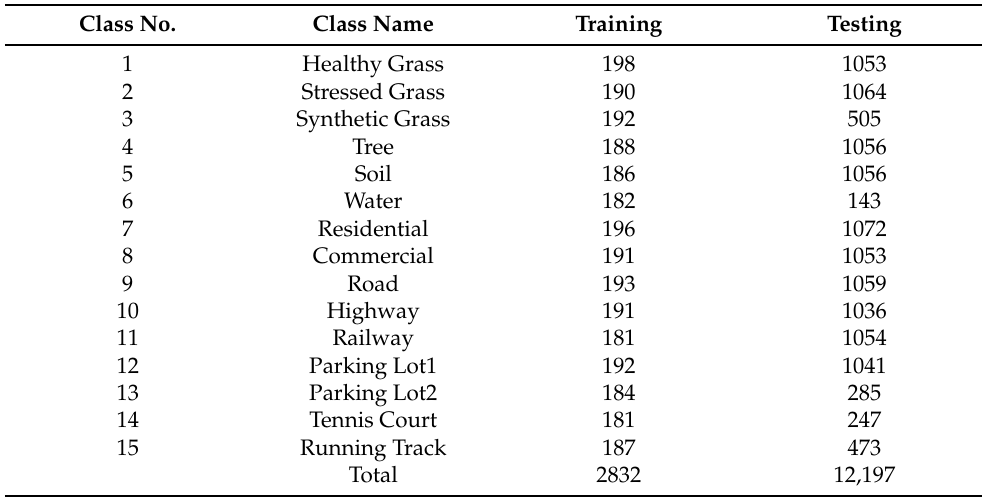
Table 5. Land-cover classes with corresponding standard training and testing pixels on Houston 2013 dataset. Class